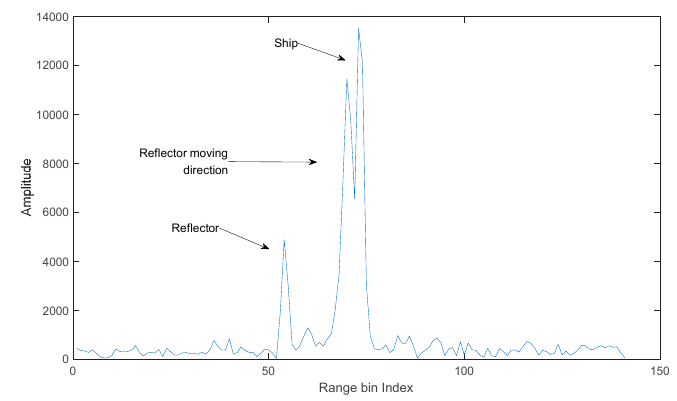
Figure 7. Range profiles of targets.